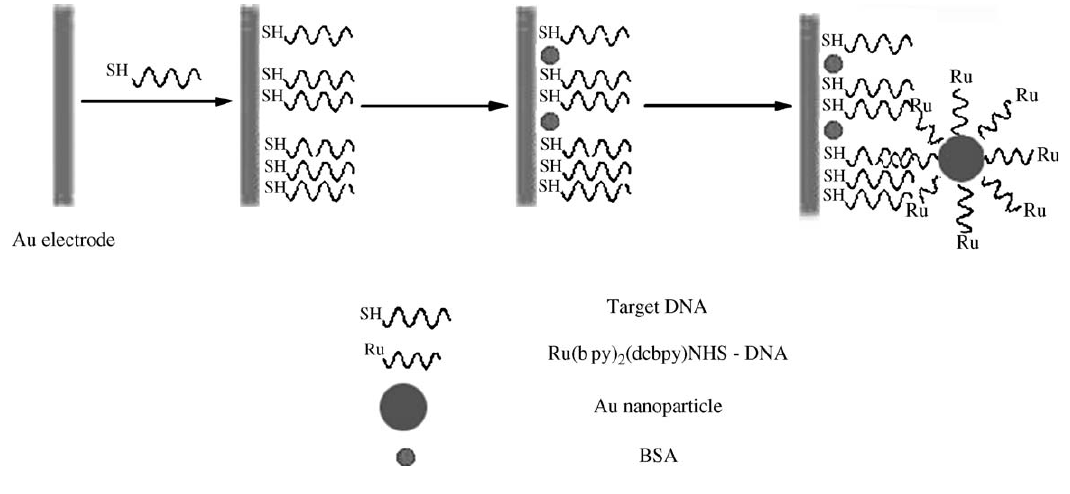
Figure 2. Schematic diagram of the ECL detection for DNA hybridization. Reprinted from Ref [58] with permission from